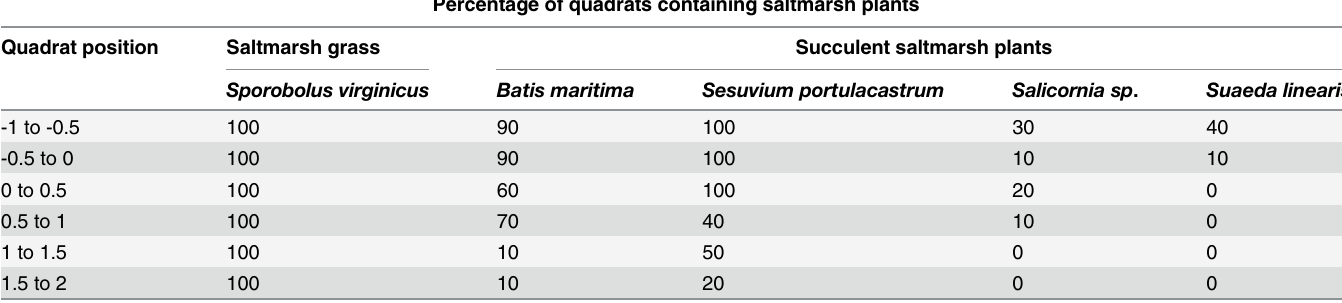
Percentage of quadrats containing each saltmarsh plant prior to the manipulation of experimental plots. To assess plant abundance, transects initiating 1 m seaward and terminating 2 m landward of the 0 m position were completed for each experimental plot. At each position along transects, saltmarsh presence was assessed within a 0.25 m 2 quadrat.